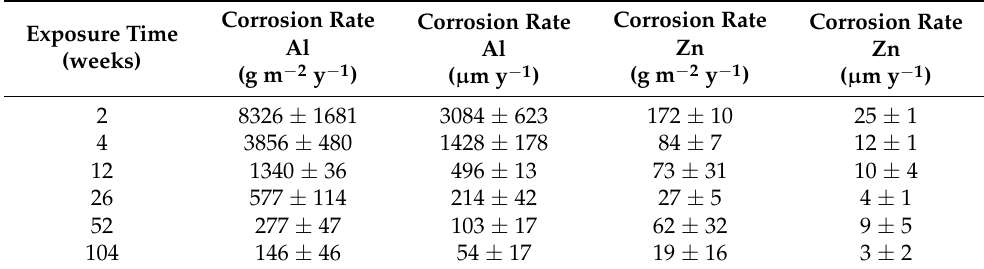
Table 3. Corrosion rates of Al and Zn immersed in oxygen free artificial groundwater for 2, 4, 12, 24, 52 and 104